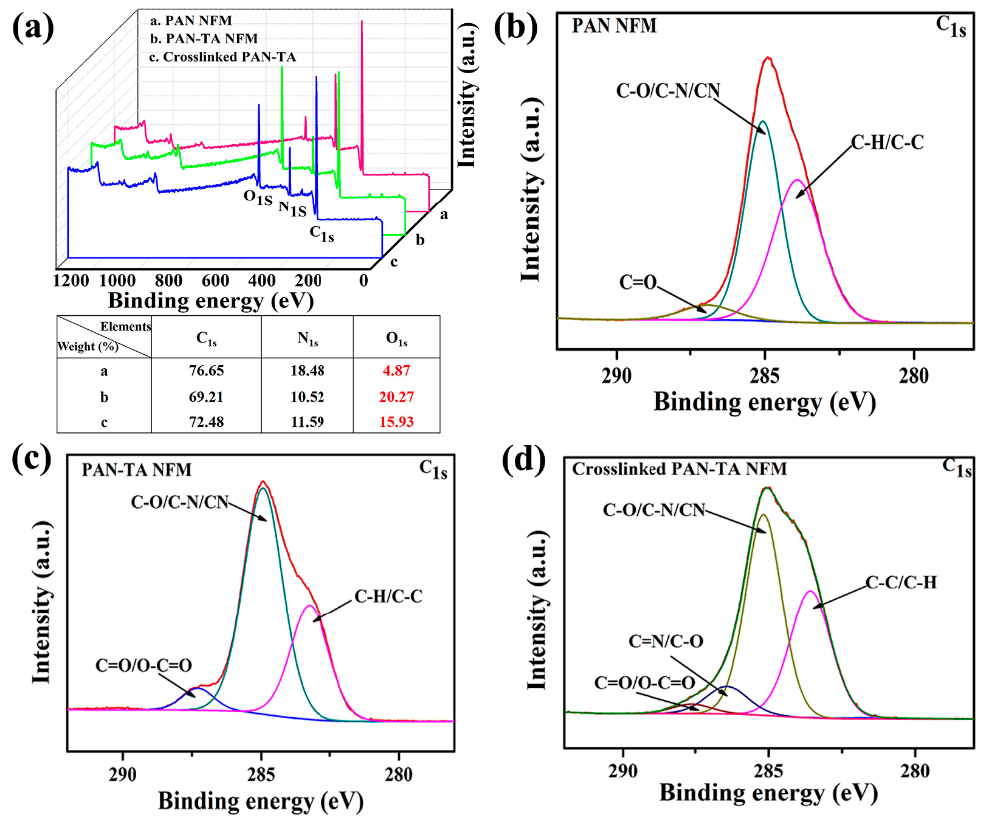
Figure 5. ( a ) XPS spectra of PAN, PAN–TA, crosslinked PAN–TA; ( b ) high-resolution scan of C1s XPS spectra of PAN NFs; ( c ) PAN–TA NFs, and; ( d ) and crosslinked PAN–TA NFs.